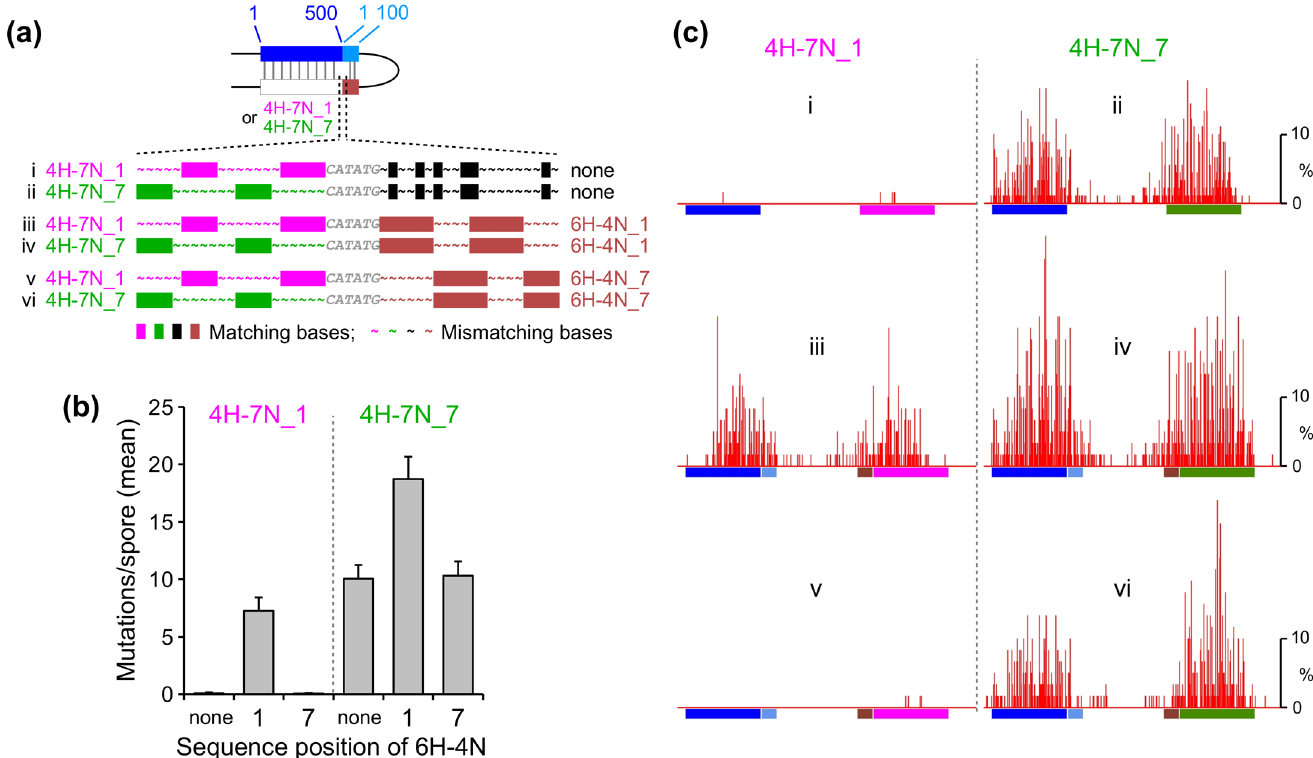
Fig 5. RIP is modulated by the underlying DNA sequence. (a) The 500-bp interspersed homologies 4H-7N_1 and 4H-7N_7 are tested in the absence of any adjacent homology ( “ none ” , same as “ 0 bps ” ) or in combination with the 100-bp interspersed homologies 6H-4N_1 and 6H-4N_7. The last homologous unit in 4H-7N_1 was inadvertently extended by one base-pair. Roman numerals correspond to the following RepeatIDs (provided in S1 Table): i —“ XIR ” ii —“ XKO ” , iii —“ XJJ ” , iv —“ XKM ” , v —“ XKC ” , vi —“ XKN ” . (b) The mean number of RIP mutations (measured as in Fig 2C) for repeat constructs described in (Panel a). (c) RIP mutation profiles for repeat constructs described in (Panel